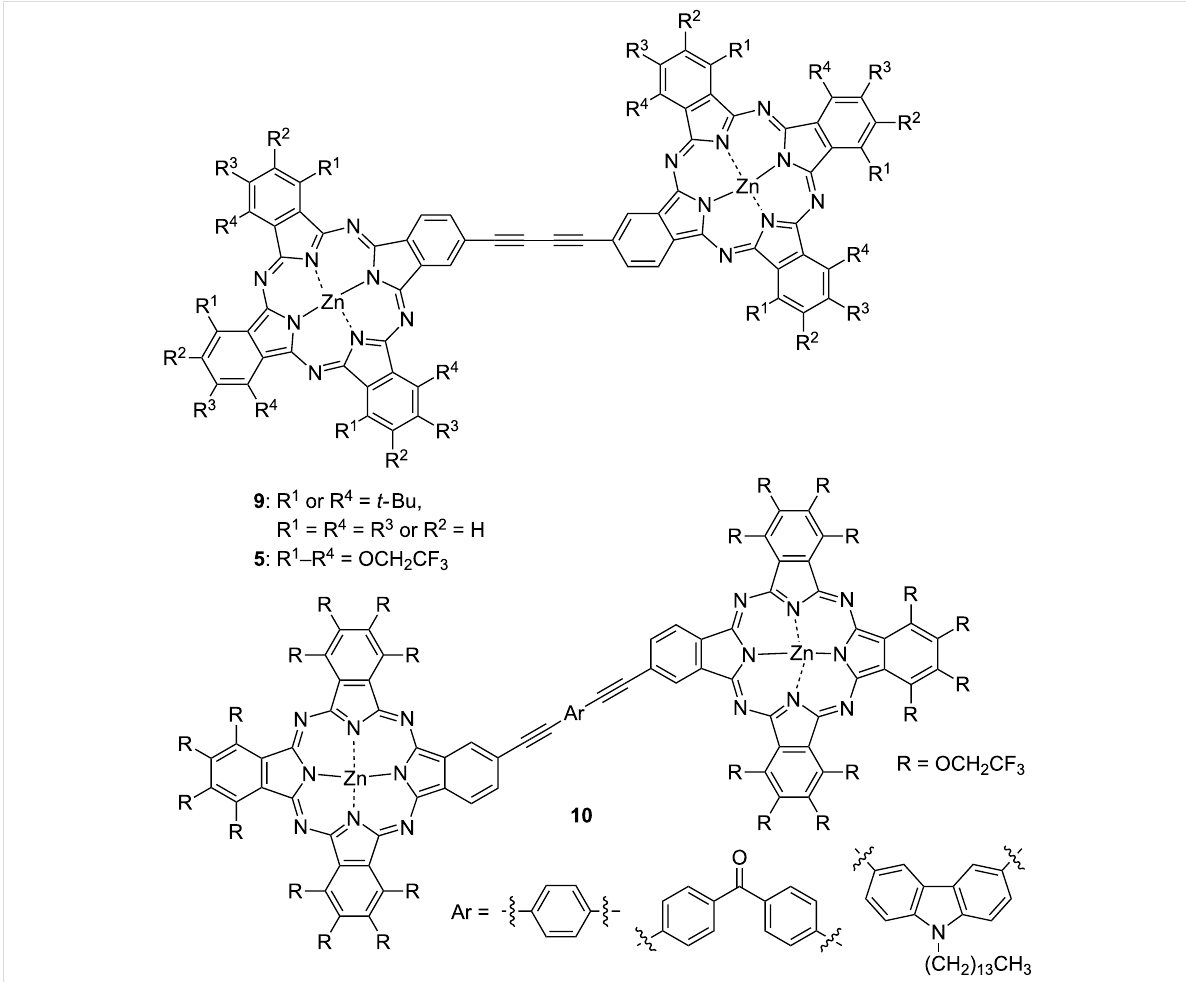
Figure 2: Structure of trifluoroethoxy-substituted dimer via a diacetylene linker.